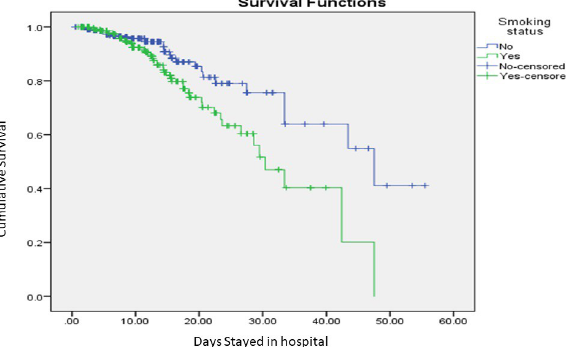
Fig 1. Kaplan-Meier survival curve for hospitalized smokers (green line) and non-smokers (blue line). p = 0.004.